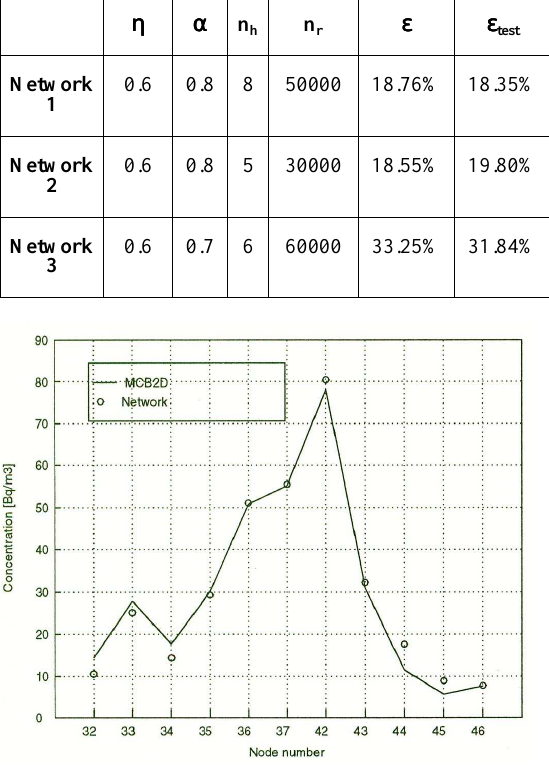
Fig. 4.10. Network 1, trained on nodes 32-37 and 42-46 v/R= 8.8 (cid:215) 10 -4 m/d, e test = 1 6.2%